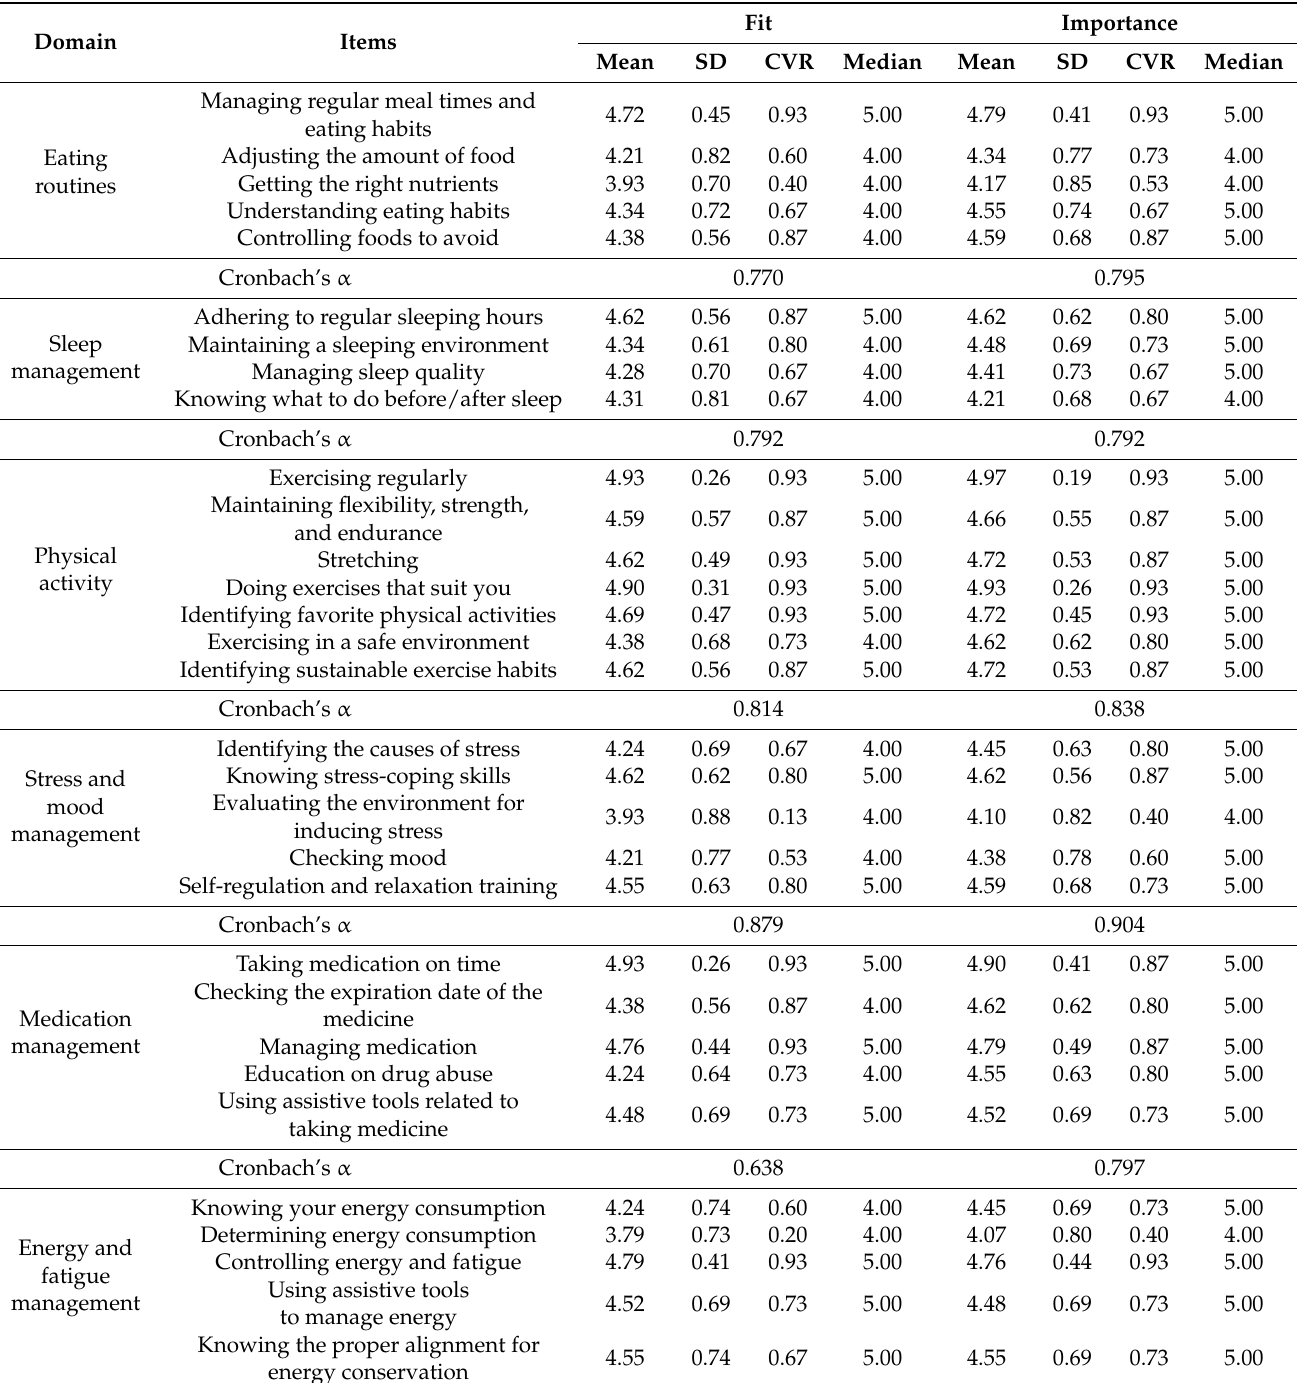
Table 3. Fit and importance of self-management items for elderly people with chronic diseases (third Delphi